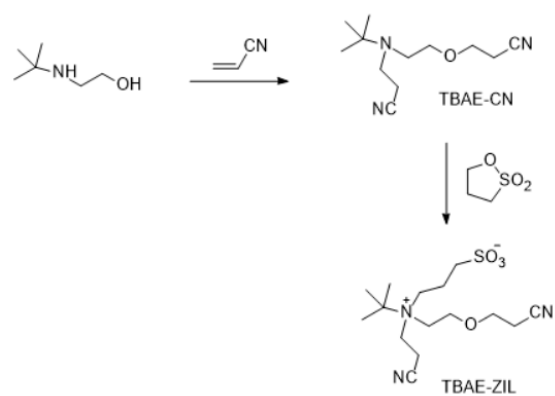
Figure 9. Synthesis of TBAE-ZIL.